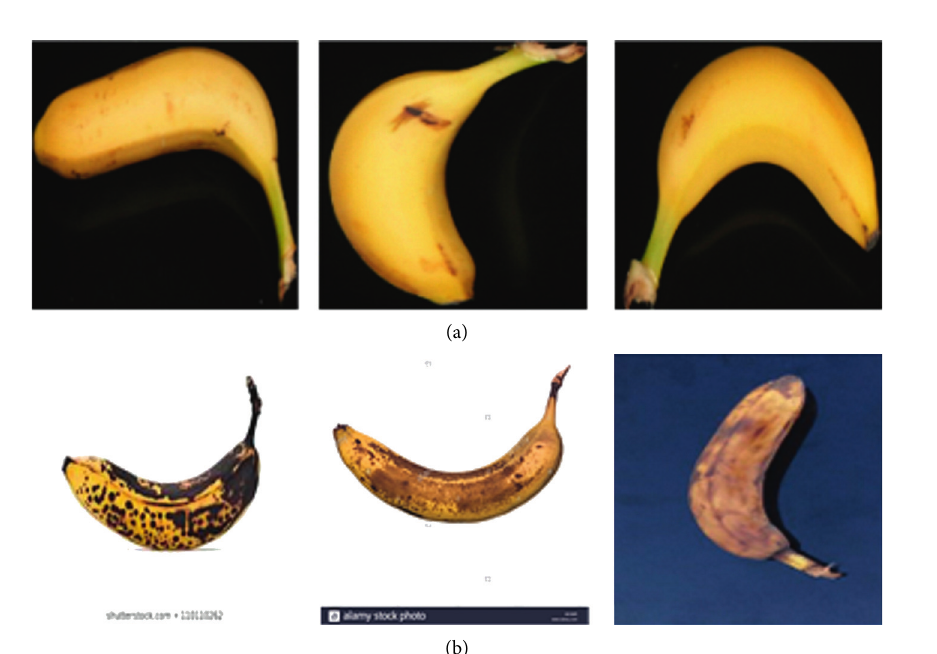
Figure 3: Sample of the databases training and testing images; (a) Healthy banana images. (b) Defective banana images.